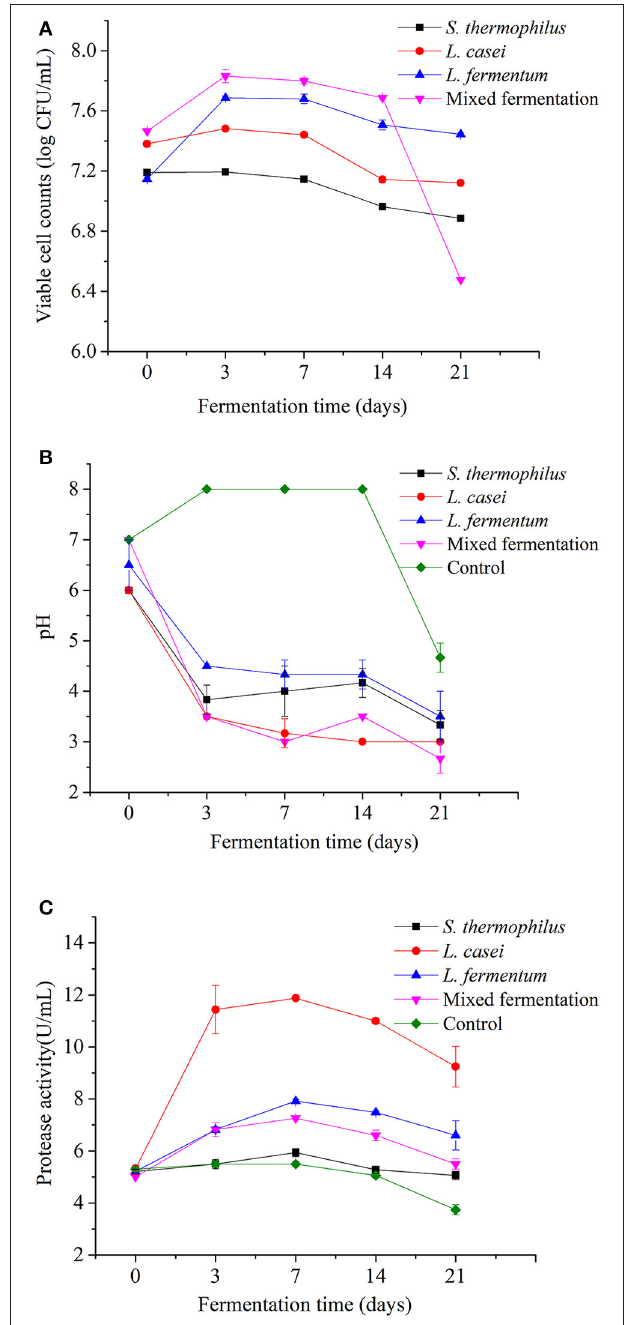
FIGURE 1 | Evolutions of viable cell counts (A) , pH value (B) and protease activity (C) of Porphyra yezoensis sauces during 21 days of LAB strains